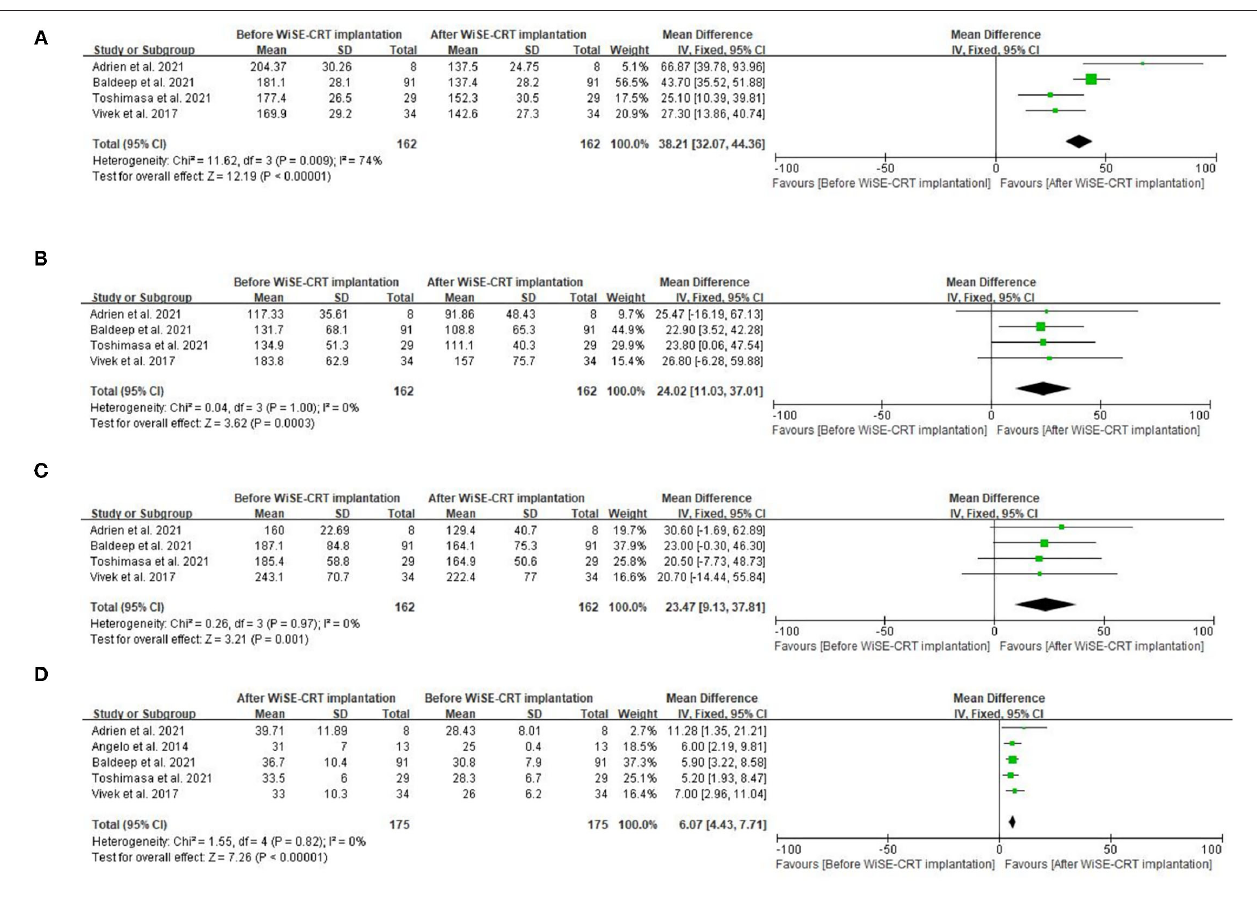
FIGURE 2 | Forest plots for the meta-analysis. (A) QRSd, (B) LVEDV, (C) LVESV, and (D)